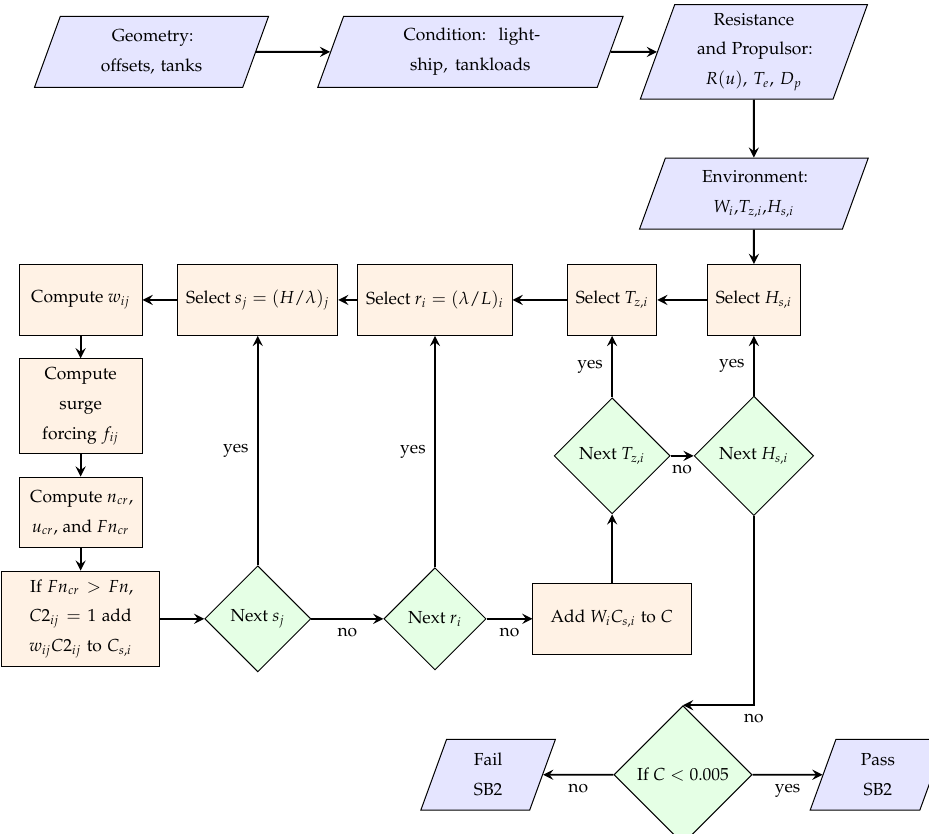
Figure 14. Surf-riding/broaching level 2 algorithm process